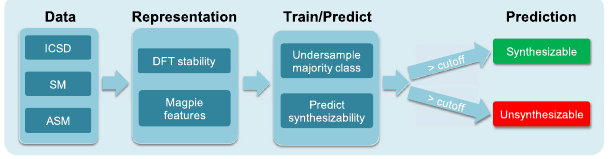
Fig. 3 Flowchart of this work ’ s modeling process. First, we calculate DFT stabilities for experimentally reported ABC compositions from the ICSD, Springer Materials, and ASM in the half-Heusler structure. The calculated stabilities are then used with composition-based features produced through Magpie to train the machine learning model. Final synthesizability labels are made based on how predicted synthesizabilities compare against empirically derived